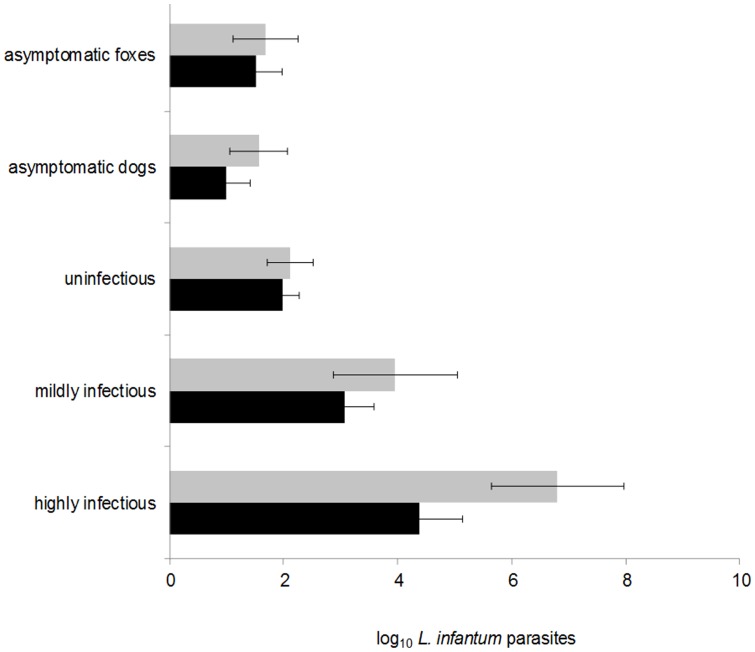
Average L. infantum parasite loads in dog and fox tissues.Parasite loads in bone marrow (light bars) and ear skin (dark bars) biopsy samples measured by real-time qPCR and expressed as mean (and 95% C.I.s) log10 parasites per mL (bone marrow) or per gram (ear skin). Samples from infected dogs are stratified by infectious status. Clinically asymptomatic dogs and foxes presented total clinical scores <3 at all clinical examinations over ≥8 months post infection follow-up. Infectiousness categories: highly infectious (n = 24 bone marrow samples; n = 9 ear skin samples); mildly infectious (n = 44, 26); uninfectious (n = 85, 60); asymptomatic dogs (n = 37, 27). Foxes were all asymptomatic (n = 67, 51).